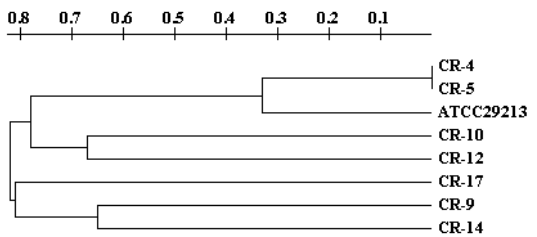
Legend: Dendrogram obtained with the software TreeCon